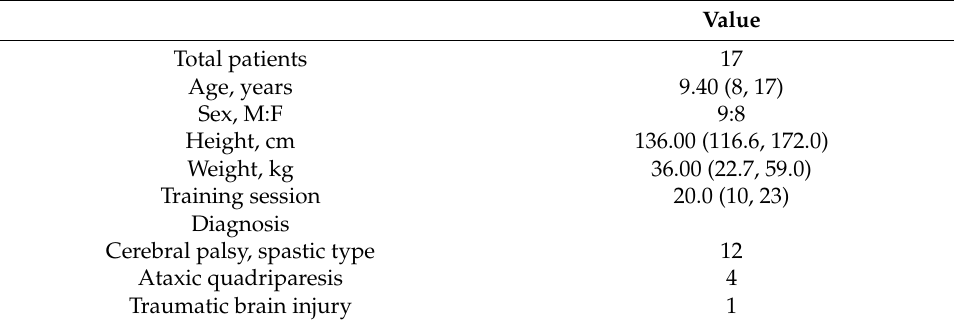
Table 1. General characteristics of the participants.